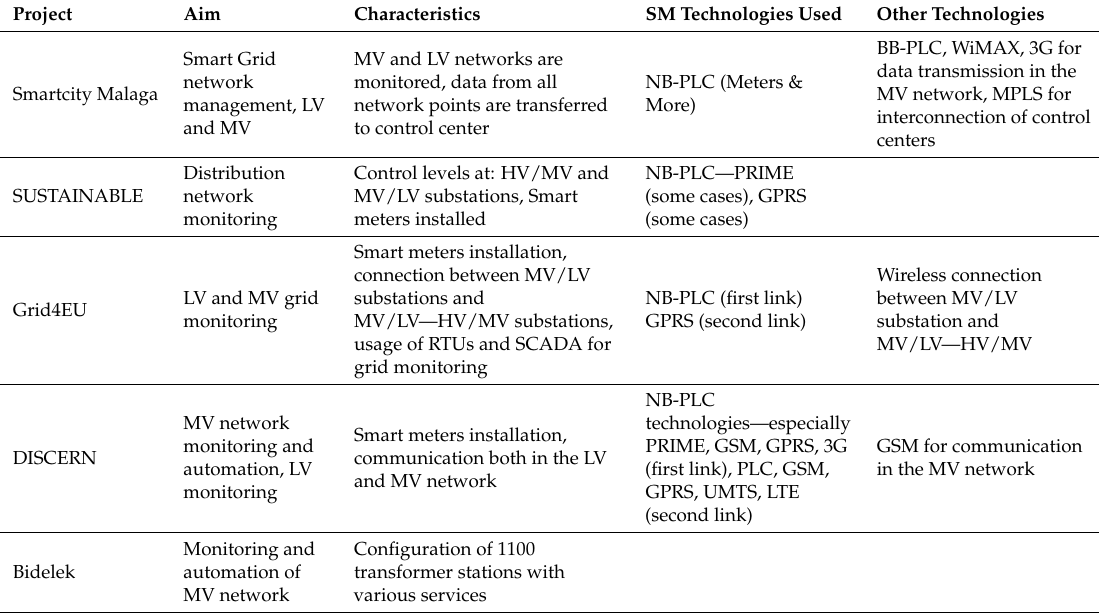
Table 9. Summary of projects for LV and MV monitoring and